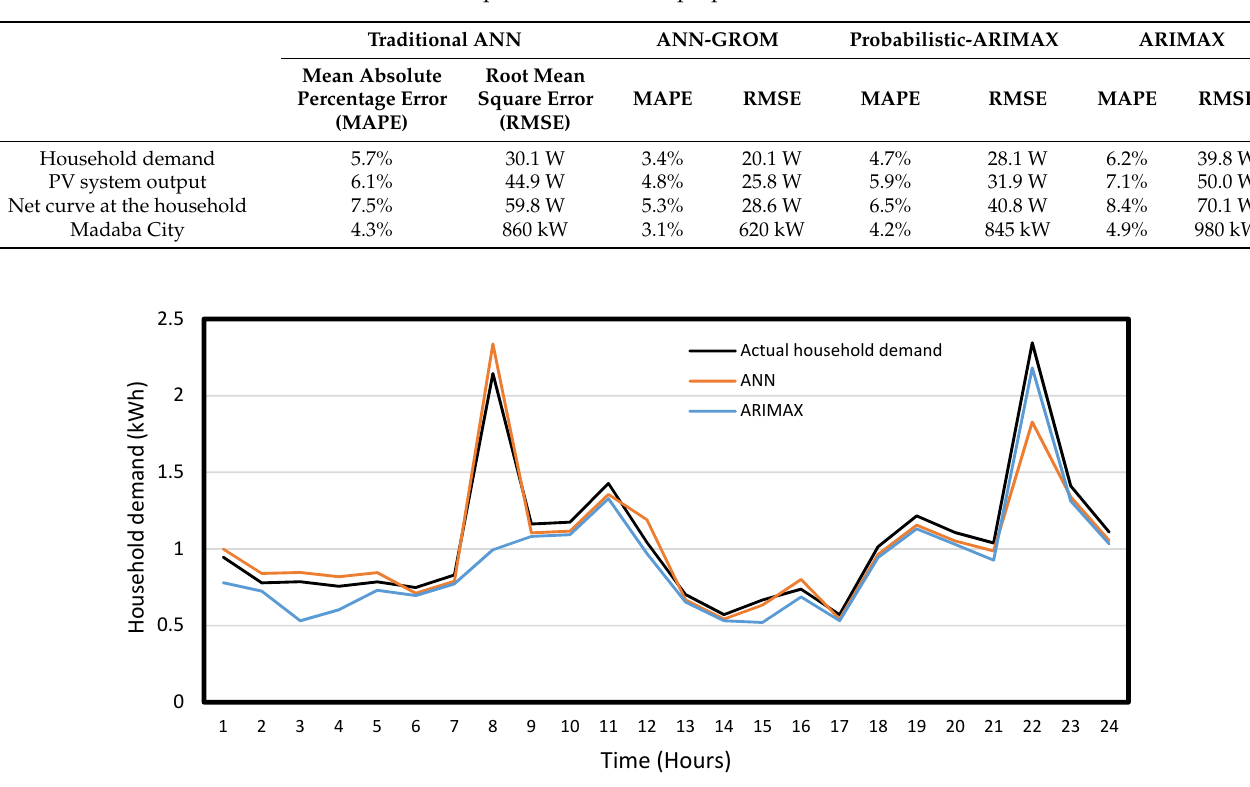
Table 6. Overall performance of the proposed forecast models.